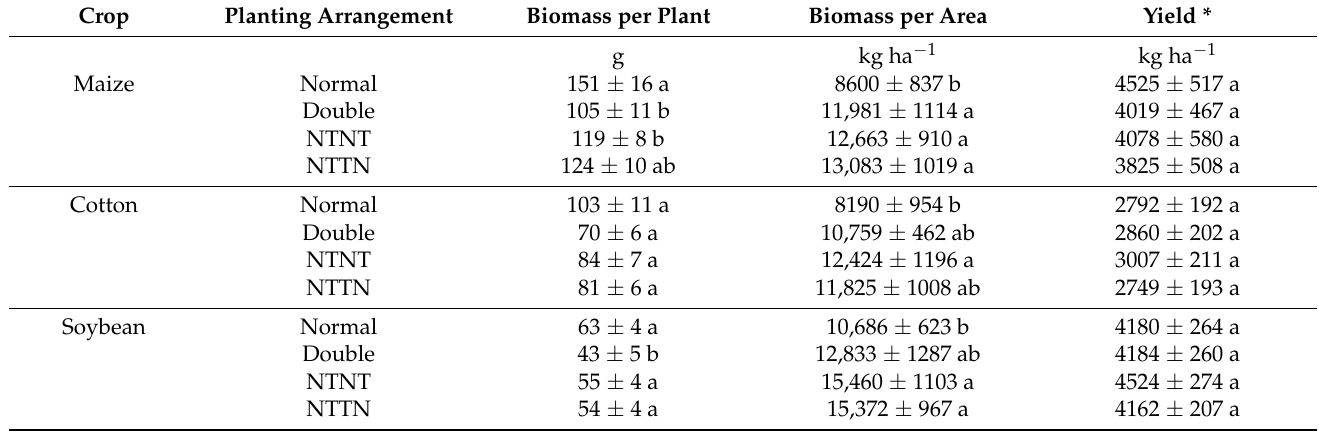
Table 4. Yield and biomass measurements for maize, cotton, and soybean for each planting arrange- ment. NTNT: a sequential arrangement of normal and tripled densities (each in every other row), and NTTN: normal-tripled-tripled-normal. Means and standard error of the means followed by a different letter indicate significant differences at p < 0.05.